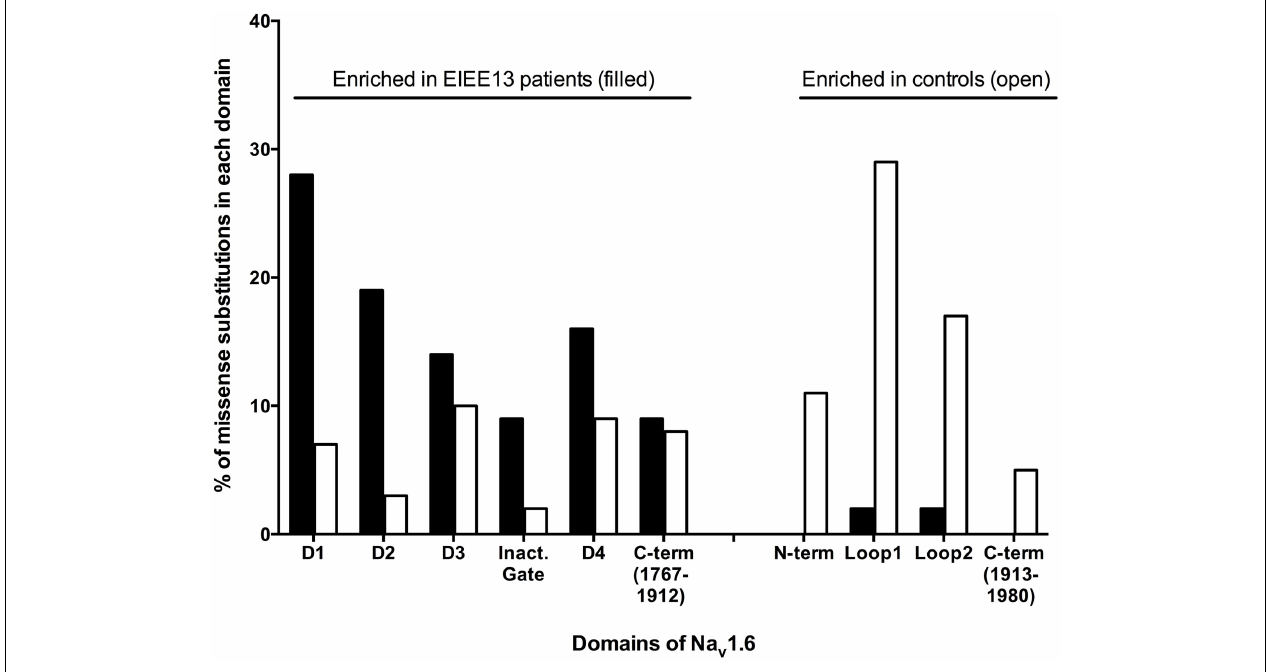
pediatric disease. Each amino acid substitution was counted once. Data were available for 43 mutations in EIEE13 patients and 228 variants from the